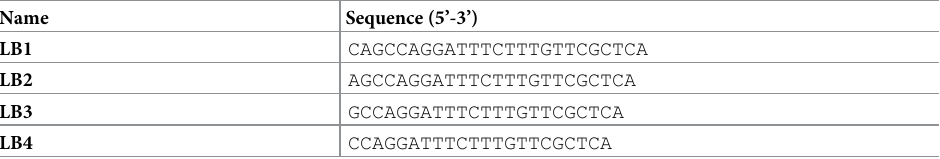
Table 2. Sequences of backward loop